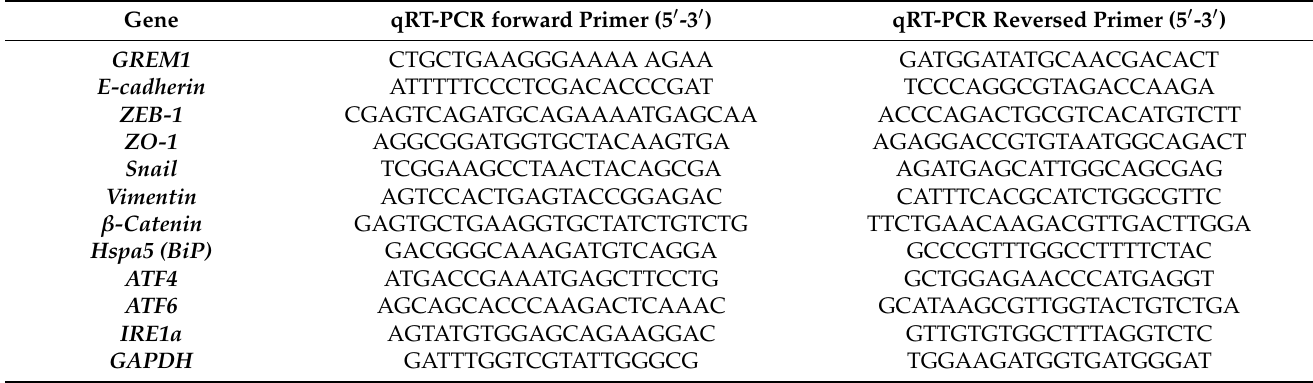
Table A1. Sequences of the primers for